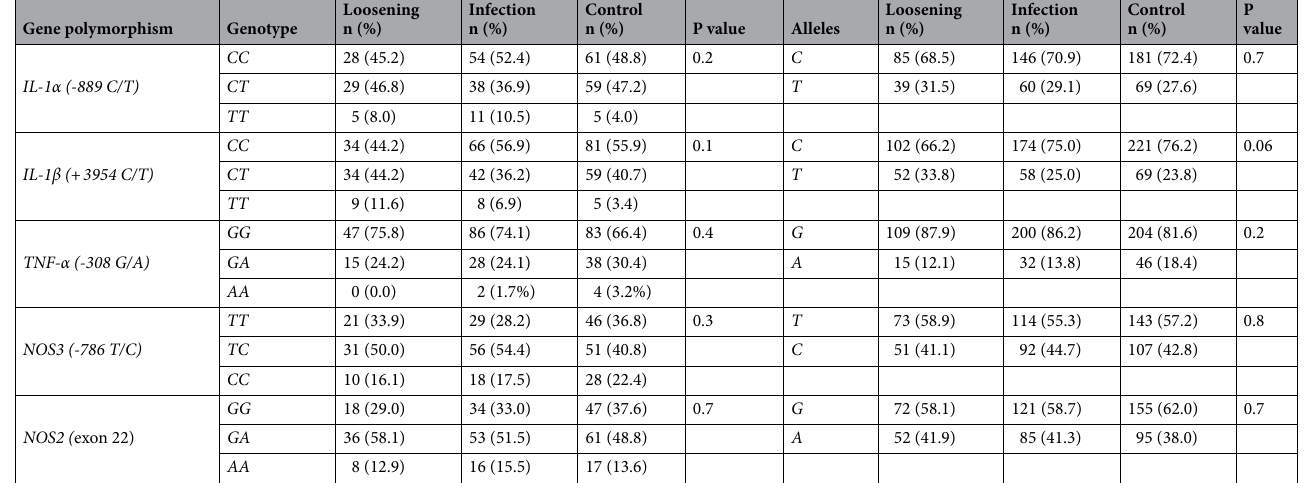
Table 4. Polymorphisms of IL-1α, IL-β, TNF-α, NOS3 and NOS2 in patients with aseptic loosening, infection and